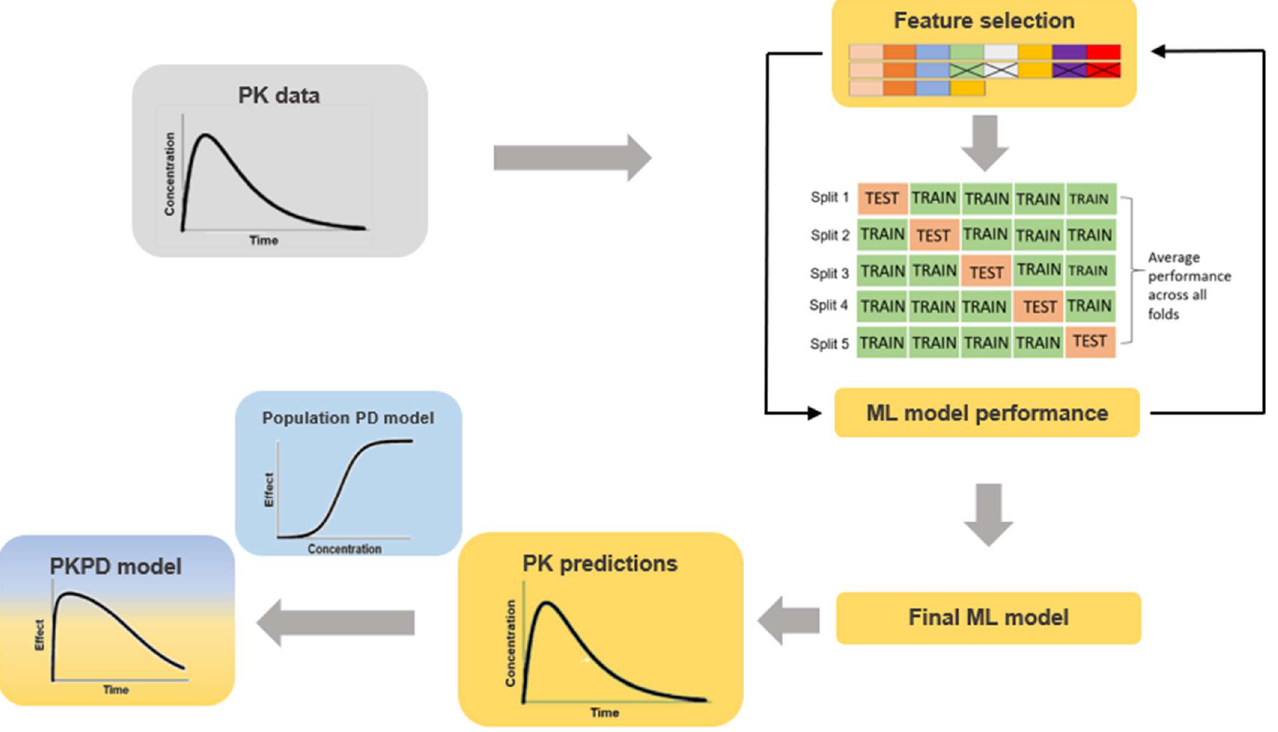
Figure 1. Overall proposed workflow. Blue panels indicate pharmacometrics and yellow machine learning.